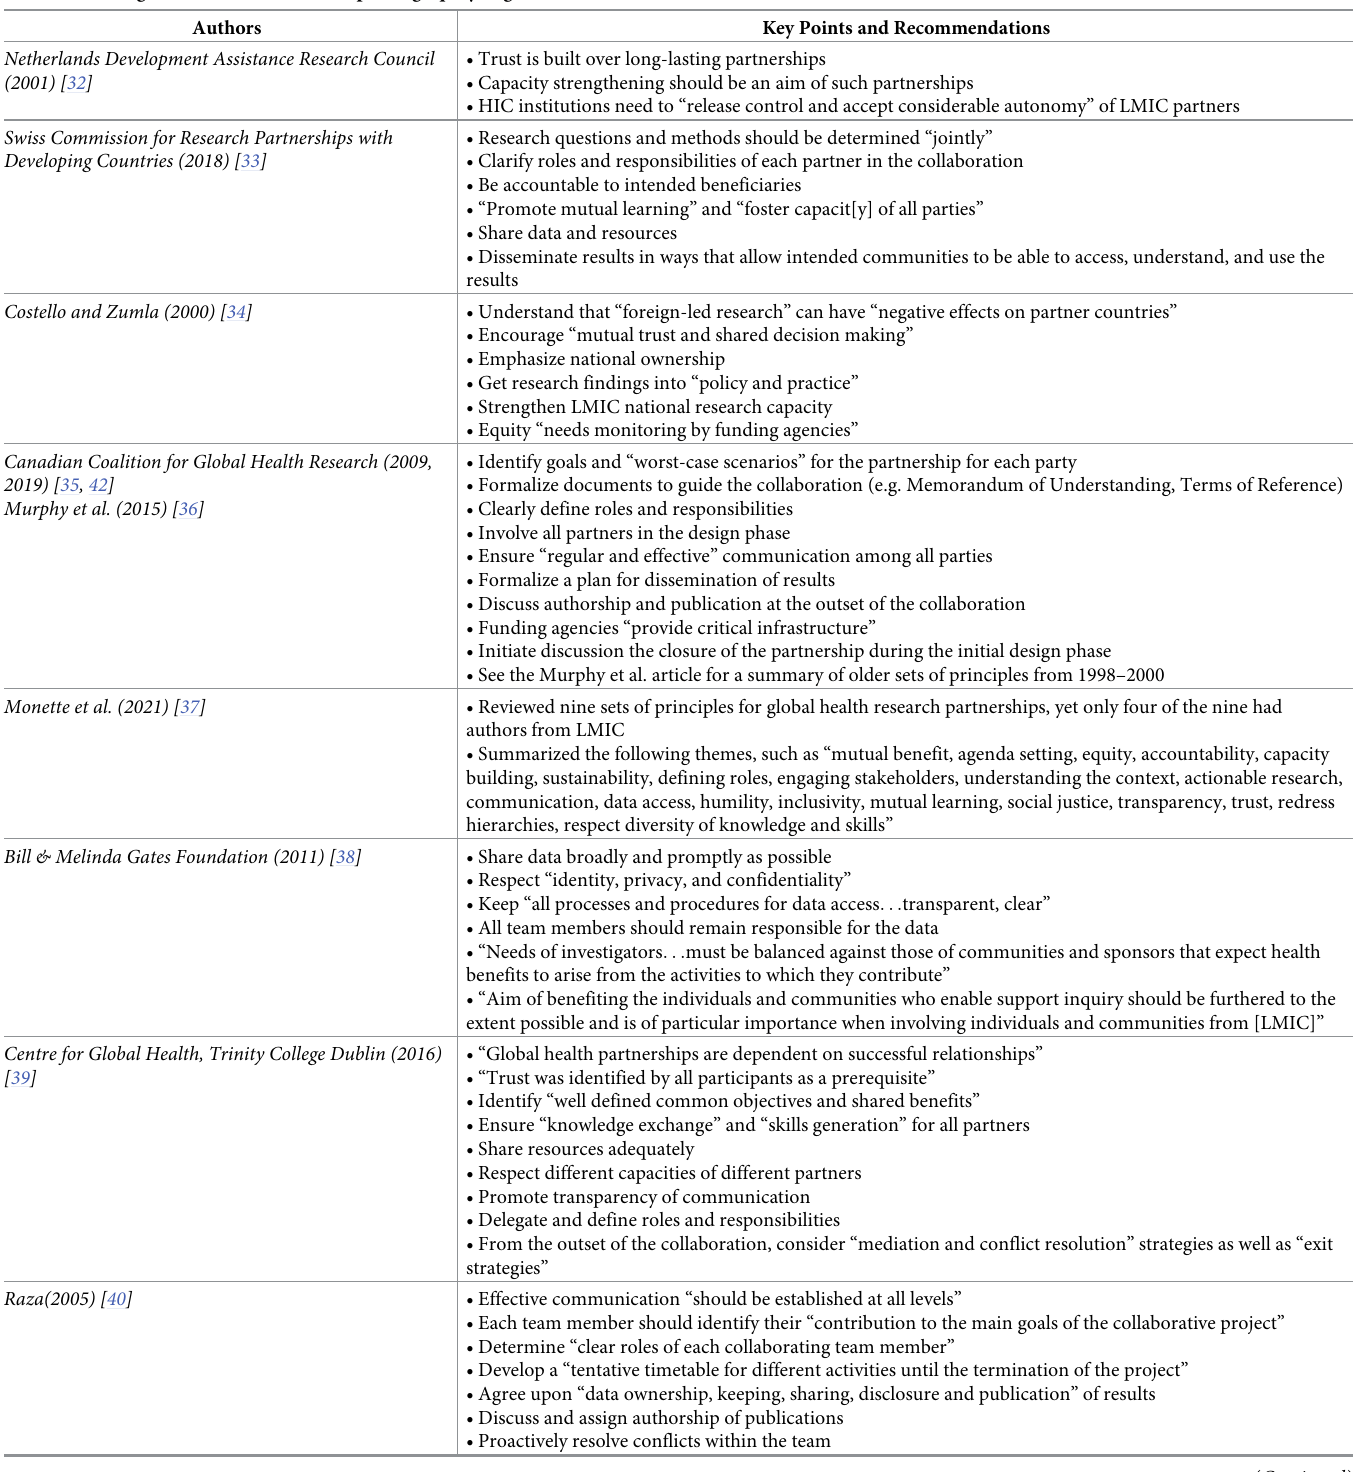
Table 2. Existing recommendations for improving equity in global health